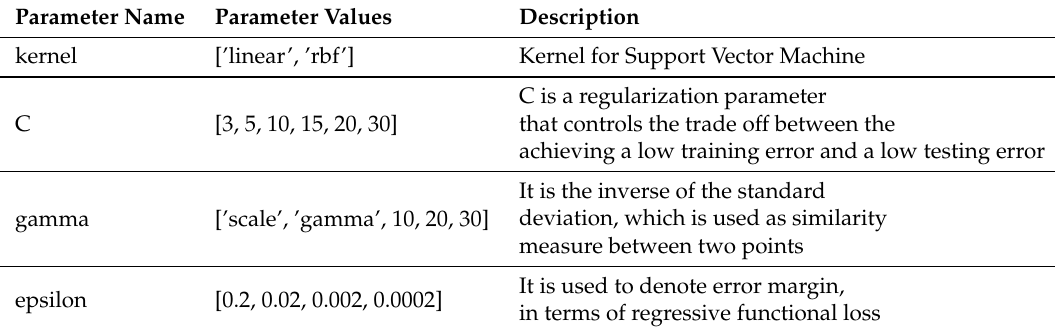
Table 3. Subset of ESVR Parameters for GS.